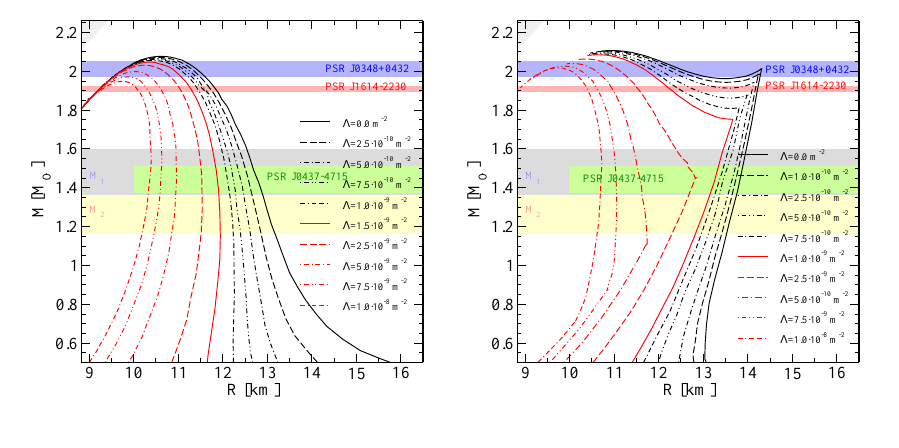
Figure 1. Mass-Radius for compact stars under the influence of a cosmological constant Λ . The shaded colourful areas correspond to measurements of neutron stars, see [14] for details. Left column: DD2 EoS. Cosmological parameter values can shrink mass and radius values, eventually changing the topology from a standard hadronic EoS (black lines) into a quark EoS (red lines) in the framework of general relativity with zero cosmological constant. Right column: High mass twins (MP-HMTs) EoS. The strength of the Λ parameter can wipe out the mass twins (black lines) leaving a quark-like EoS (red lines) with a characteristic kink due to the strong first order phase transition in the HMTs EoS. This phenomenon is similar to an internal softening of the EoS when a mixed phase featuring geometrical structures appear [25, 26], however no kink is present in that